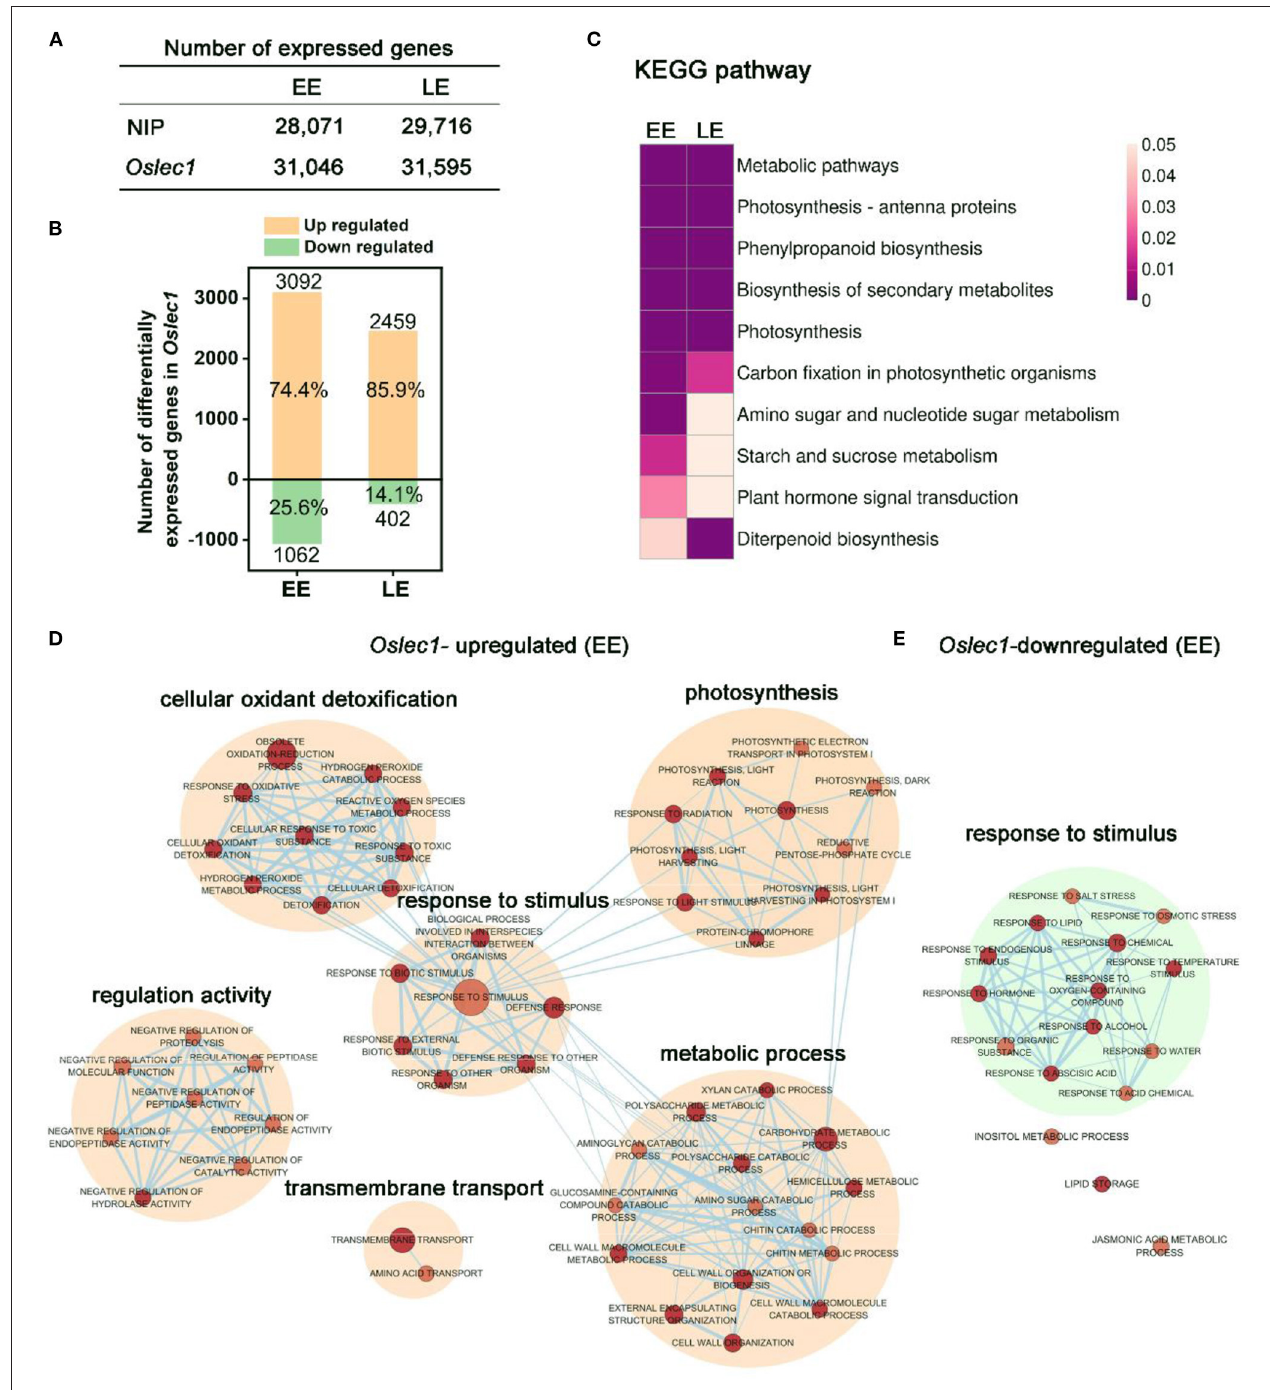
FIGURE 4 | mRNA profiling of Oslec1 mutant embryos at early (EE) and late (LE) development stages. (A) The number of differentially expressed genes detected in wild type and Oslec1-1 embryos at EE (7 DAP) and LE (25 DAP) stages. (B) The number of upregulated and downregulated genes in Oslec1-1 embryos compared with that in wild type plants. (C) KEGG pathway analysis of differentially expressed genes detected in wild type and Oslec1-1 embryos at EE and LE stages. (D,E) GO term analysis of upregulated (D) and downregulated (E) genes in Oslec1-1 embryos compared with those in the wild type ones. response to stimulus include response to water, ABA, hormones, harvesting, and light reactions, consistent with the embryo and temperature stimulus ( Figure 4E ), consistent with the greening phenotype of Oslec1 mutants ( Figures 2 , 4D ). The desiccation intolerant and rapid germination phenotypes GO terms for Oslec1 -downregulated mRNAs involved in